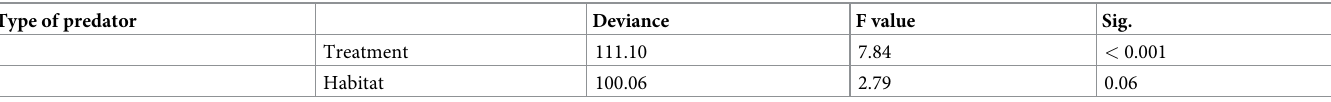
Table 6. Type of predators in relation to habitat and treatment (General Linear Model using visual/olfactory predator as response variable, N = 91 nests). Type of predator